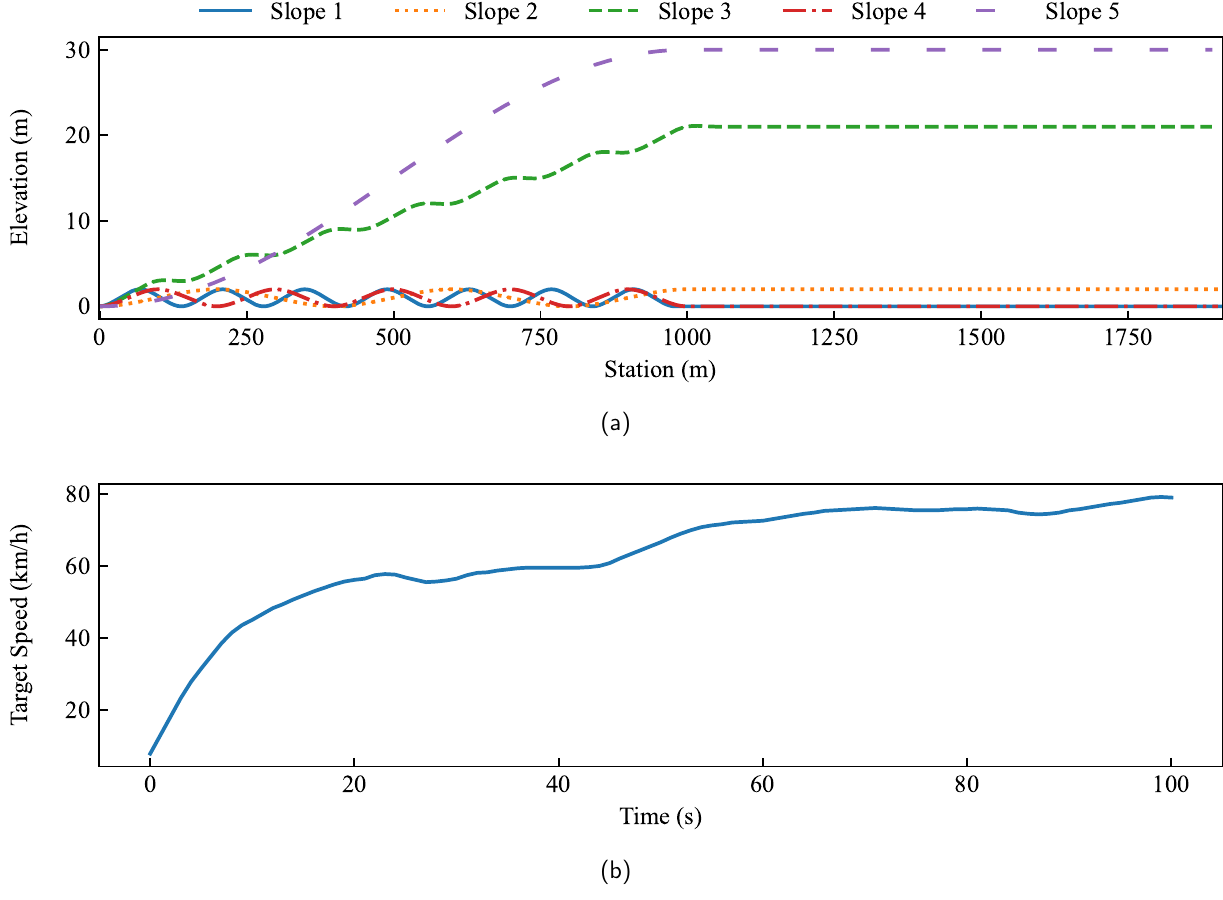
( Slopes profiles. ( ) Speed profiles. a ) b : : :::::: ::::::: : : : ::::: :::::::